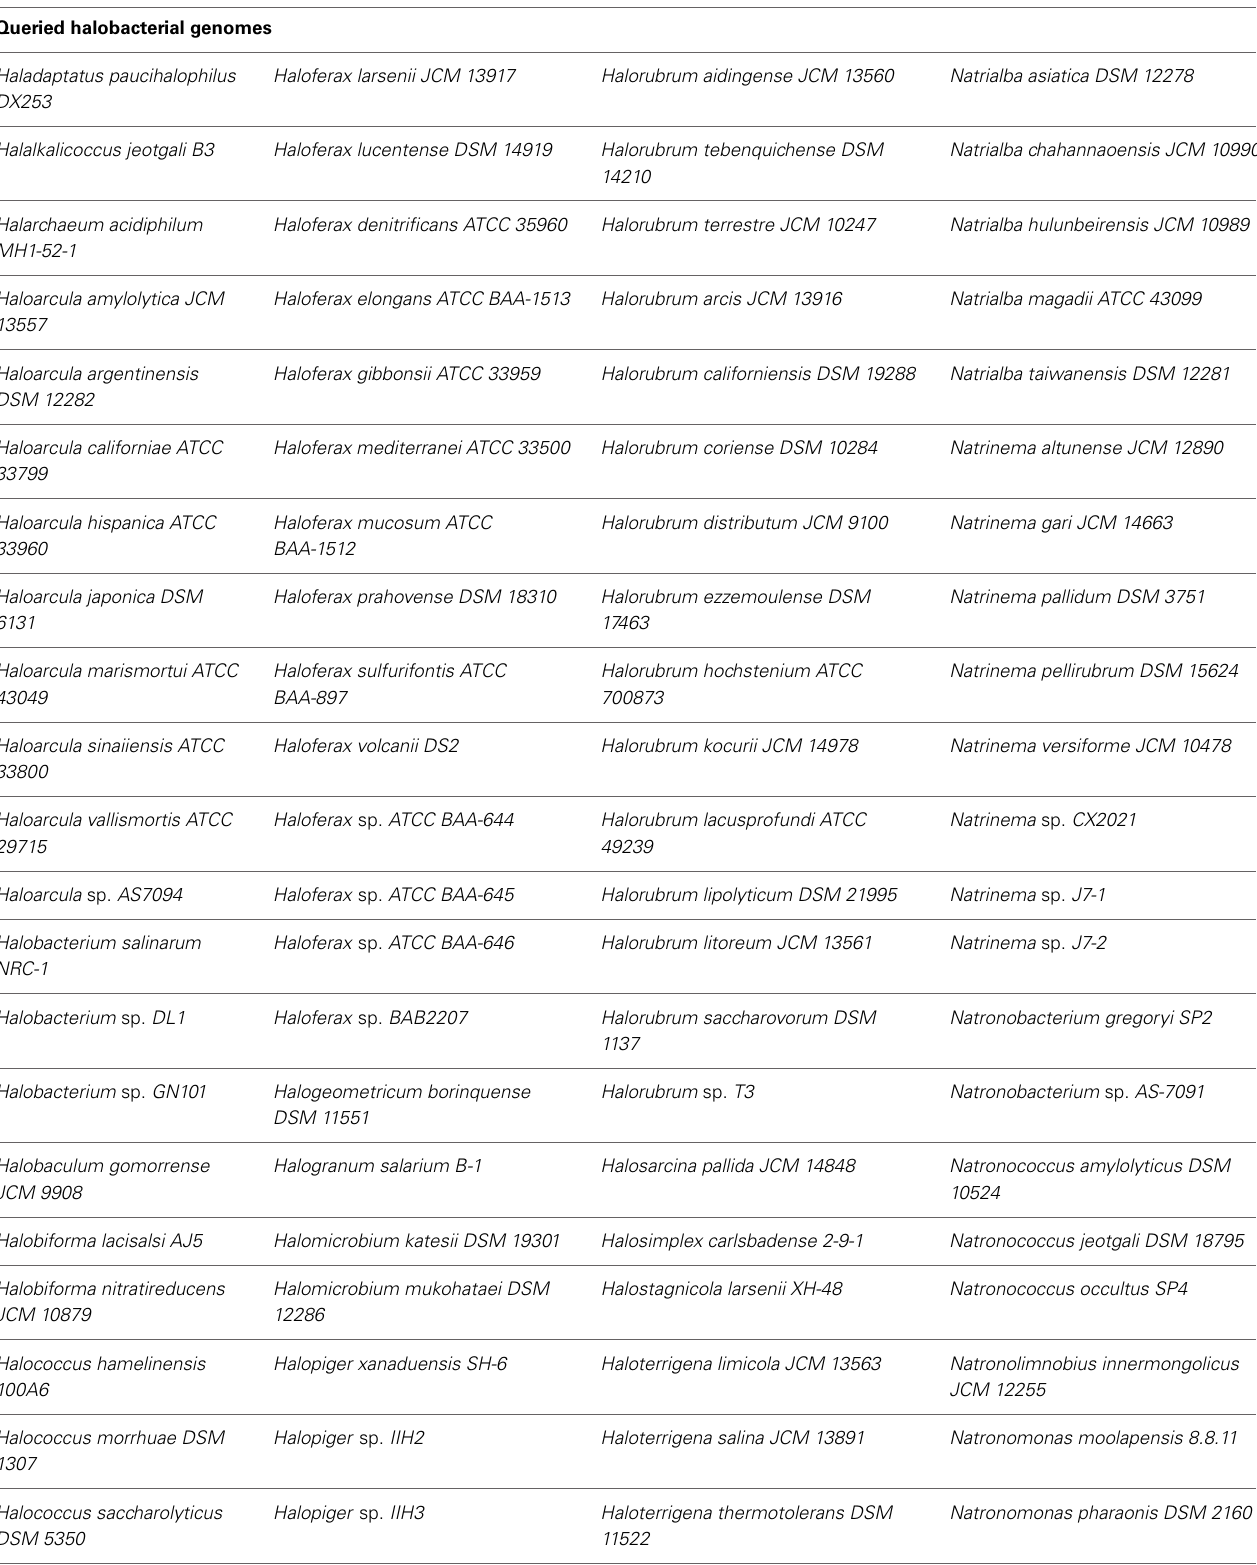
Table 3 | List of halobacterial genomes queried in BLASTp search. Queried halobacterial